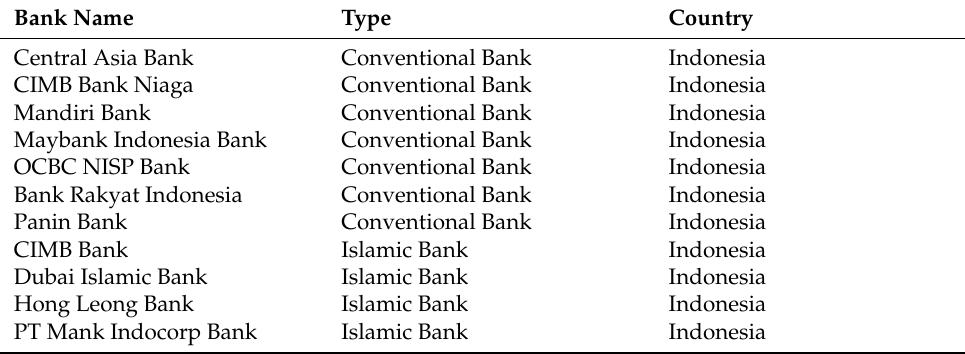
Table A1. List of